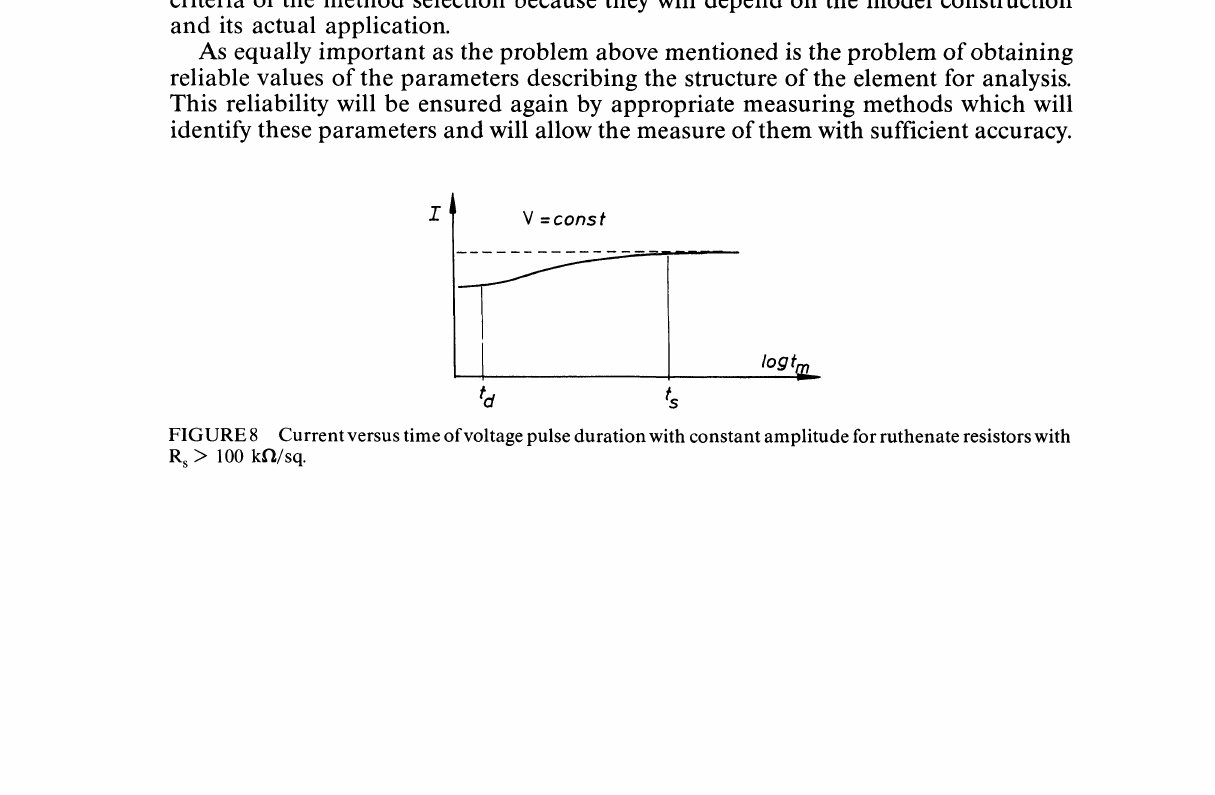
FIGURE 8 Current versus time of voltage pulse duration with constant amplitude forruthenate resistors with R > 100